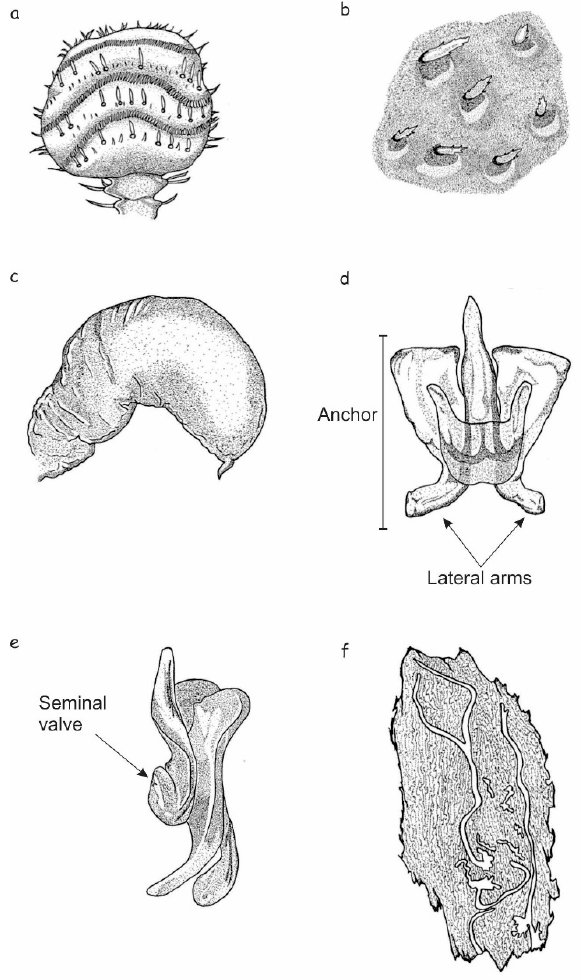
Figure 10. Dendroctonus barberi : ( a ) Antennal club, ( b ) elytral sculpturing, ( c ) spermatheca, ( d , e ) seminal rod in dorsal and lateral view, ( f ) parental tunnels in host bark.